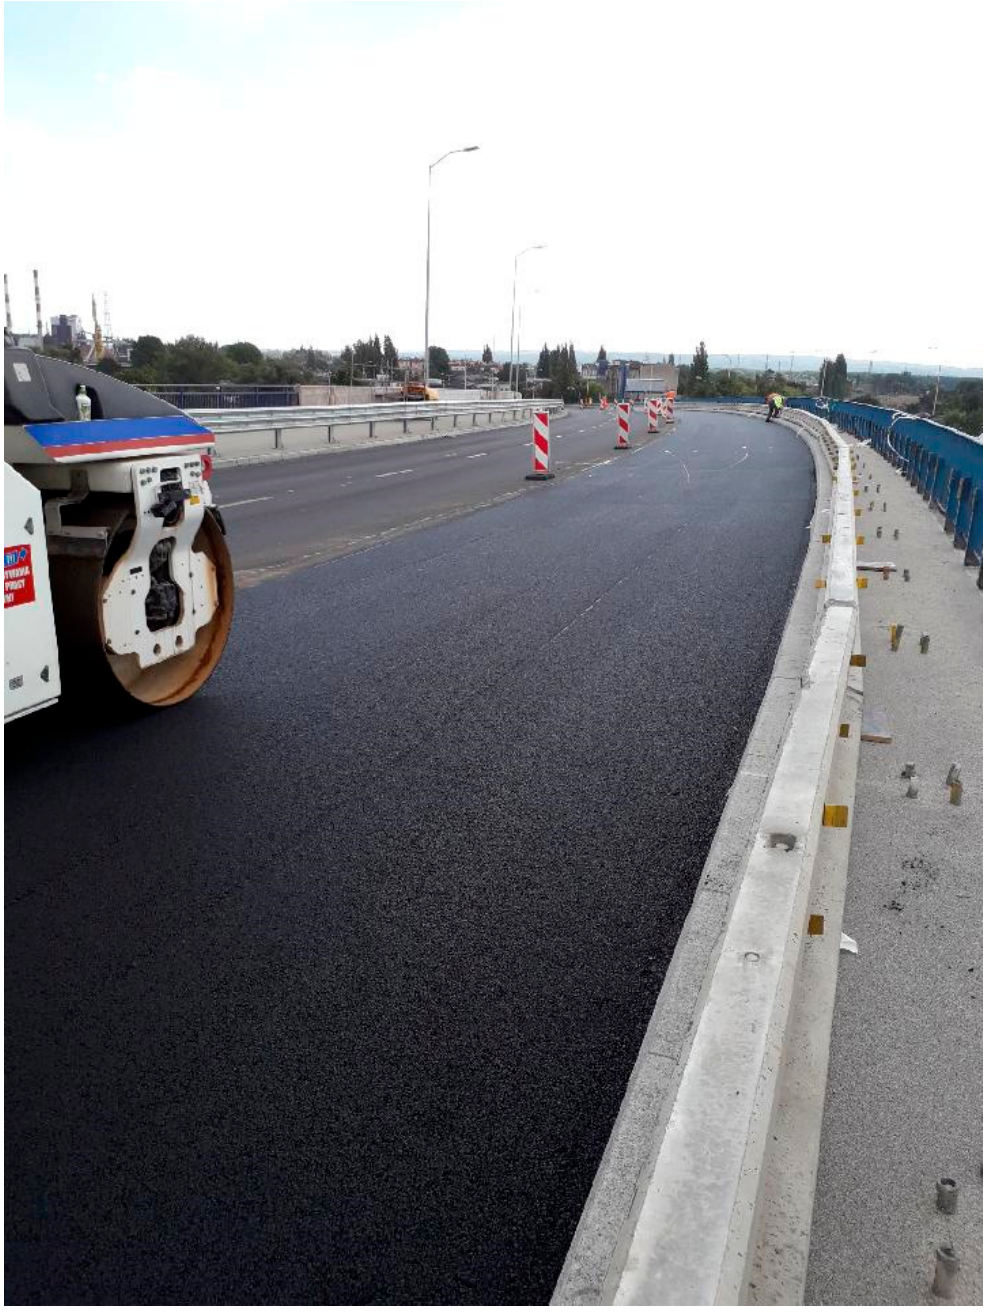
Figure 17. Compaction of binder course of asphalt concrete (AC) 11 S PMB 45/80-65 mixture.